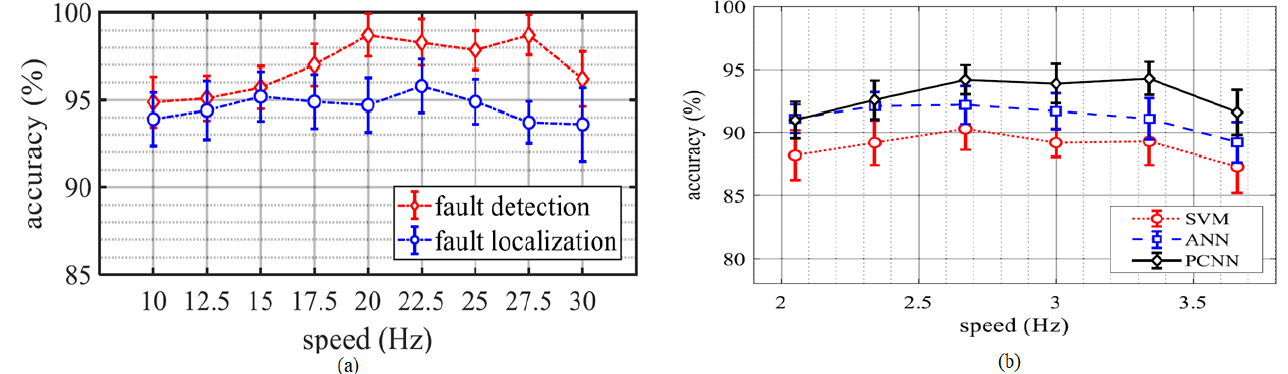
Figure 47. ( a ) Speed tests for the diagnosis of bearing faults using PCNN. ( b ) Comparison of fault detection and localization results with SVM and ANN. Reproduced with permission of [121].